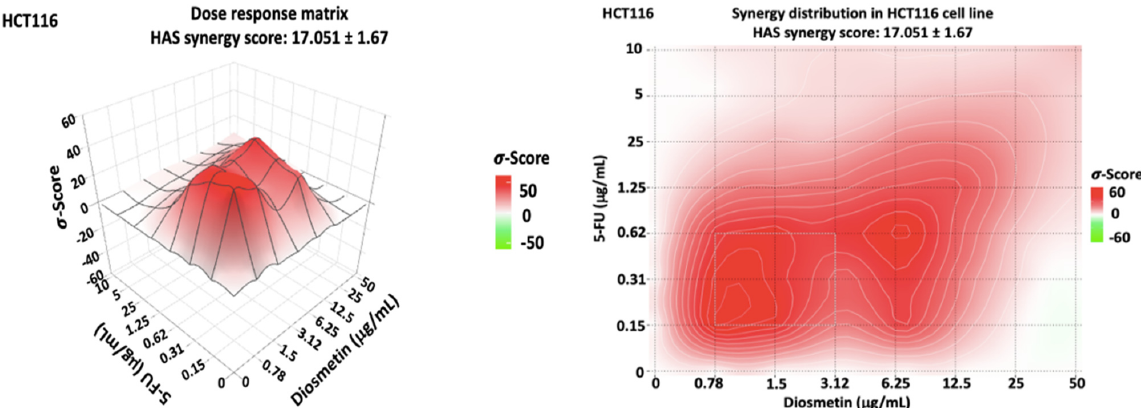
Figure 9. Dose–response matrix and synergy distribution in HCT116 cells treated with combination therapy. SynergyFinder 2.0 software was used for this analysis. Data were obtained from three individual experiments. The mean synergy score was 17.051 ± 1.67.